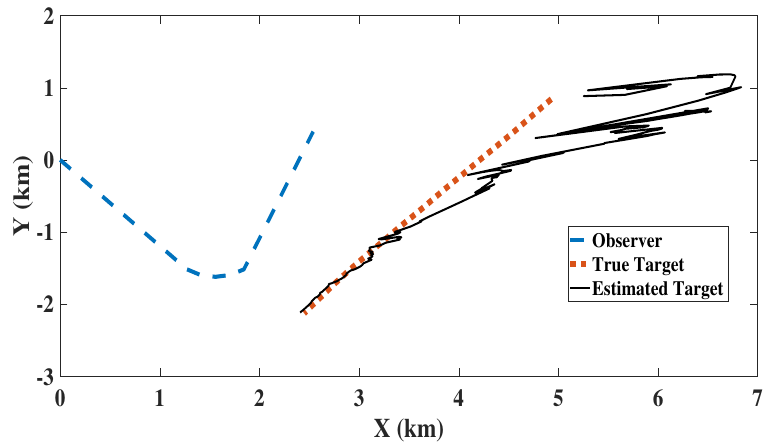
Figure 4. Target truth and estimated path obtained from MC-NSKF-CK.